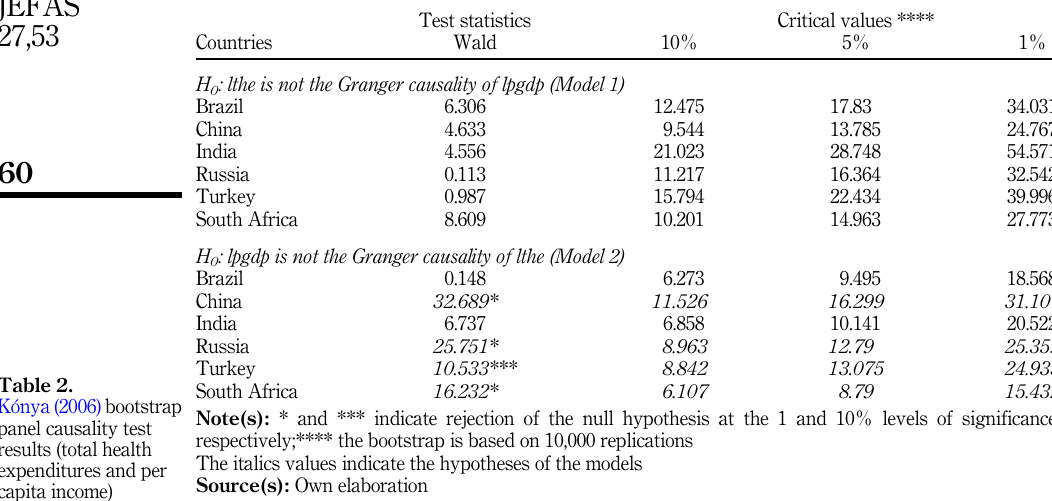
Table 2. K (cid:2) onya (2006) bootstrap panel causality test results (total